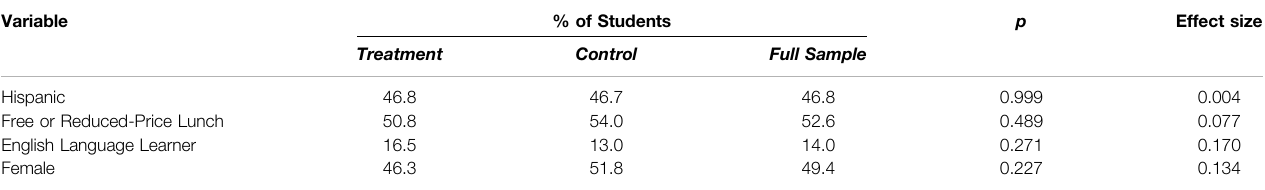
Table 2 | Student demographic information for the full impact sample by condition Variable % of Students